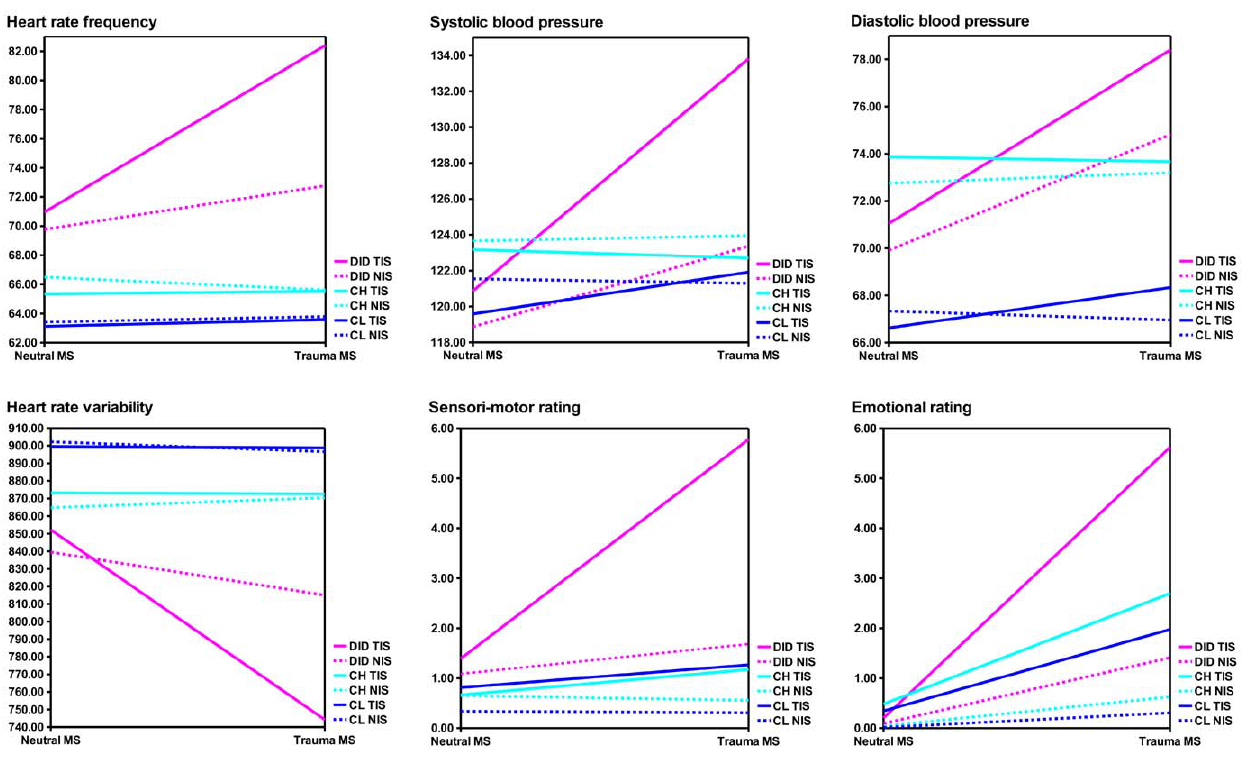
Figure 1. Graphical representation of averages and direction of subjective emotional experiences, subjective sensori-motor experiences, and cardiovascular responses. The dashed line depicts the response of the neutral identity state (NIS) when listening to the neutral or trauma-related memory script (MS). The solid line depicts the response of the traumatic identity state (TIS) when listening to the neutral or trauma related MS. All three groups are presented per variable: the dissociative identity disorder patients (DID) in pink, the high fantasy prone DID simulating controls (CH) in cyan and the low fantasy prone DID simulating controls (CL) in blue. See Table 1 for the statistical values.